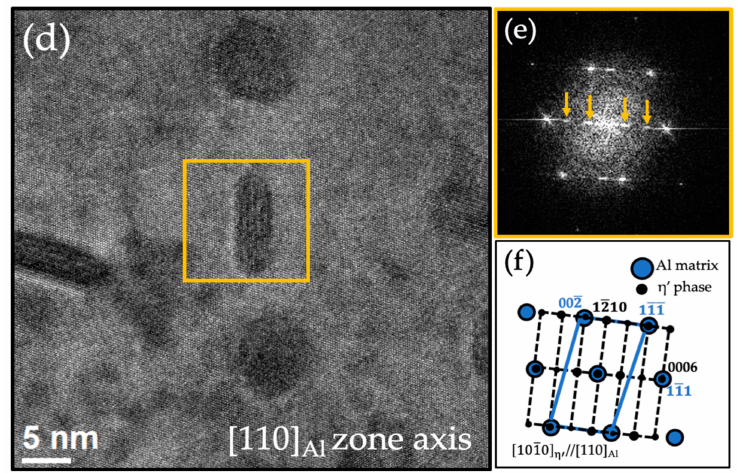
Figure 6. HR-TEM images, FFT diffractograms, and corresponding simulated diffraction patterns of η (cid:48) precipitates of 7075-LCu obtained from the PA conditions at ( a – c ) 120 ◦ C, and ( d – f ) 160 ◦ C.